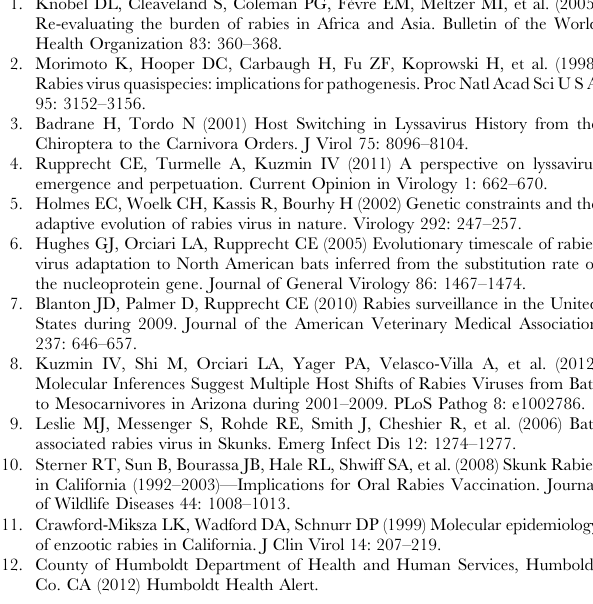
red pixels, and variants that occur at lower frequencies in an cumulative frequencies is . 1% appear as blue vertical streaks. Sample IDs are ordered by date. Colored lines on the bottom indicate genomic regions. Positions are not consecutive as only 248 genomic locations are shown. Figure S10 Distribution of variants detected by Illu- mina sequencing across the rabies genome. Only those variants (N = 248) that occurred at above 1% either in one sample or have a cumulative frequency . 1% over all samples are included for this analysis. Dashes at the bottom indicate intergenic regions. A. Number of variants found in each genomic region. B. Per-nucleotide rate of occurrence of these variants in each genomic region. Table S1 Primers used to amplify rabies samples. Table S2 Sample metadata. Sample collection date and location (city or county) are listed. In many cases the street location was obtained for a sample and this information was used for placement of the sample in Figure